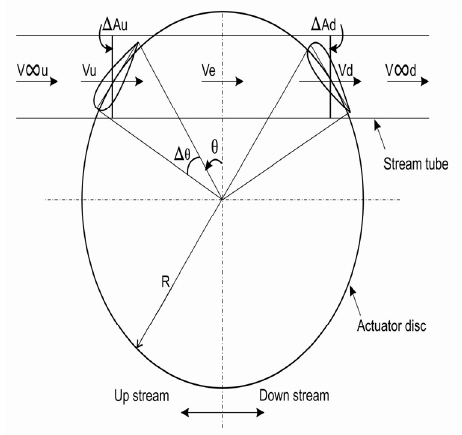
Figure 1. Momentum Analytical Method (Double Multiple Stream